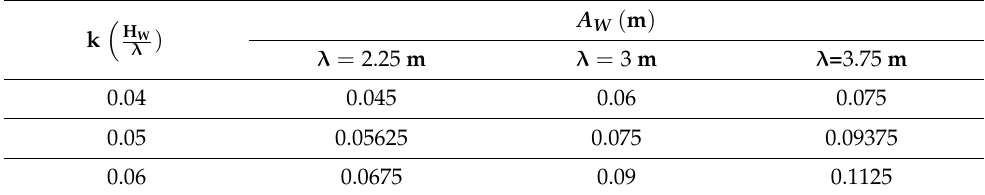
Table 1. Regular head wave conditions used for the simulations.